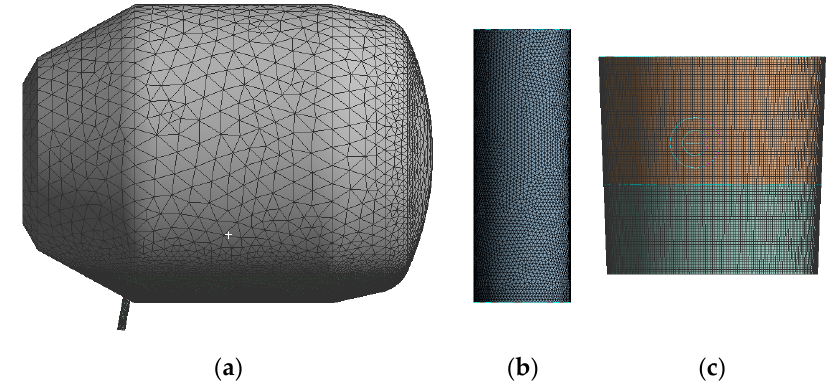
Figure 2. Diagram meshing of ( a ) converter; ( b ) surround; ( c ) ladle.